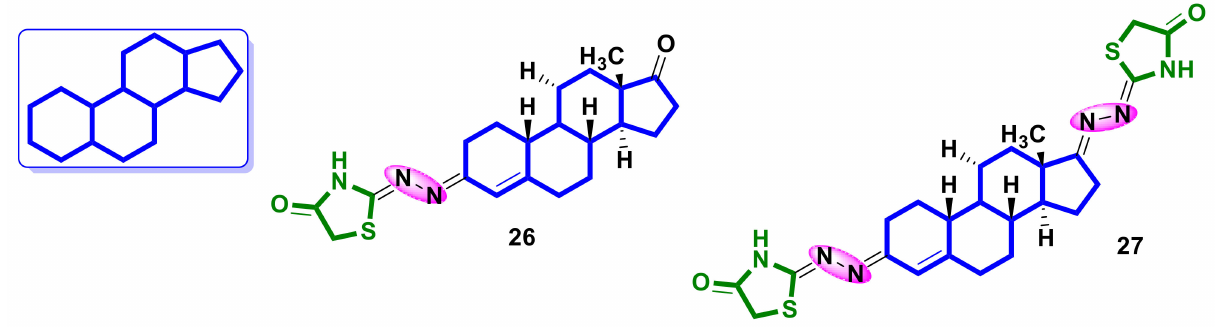
Figure 11. Structures of steroid–4-thiazolidinone